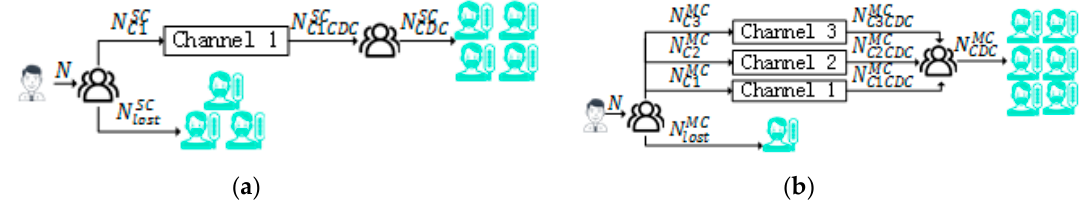
Figure 3. The Logical Structure Model of a Solitary Channel and Multiple Channels. ( a ) Solitary Channel; ( b ) Multiple Channels.